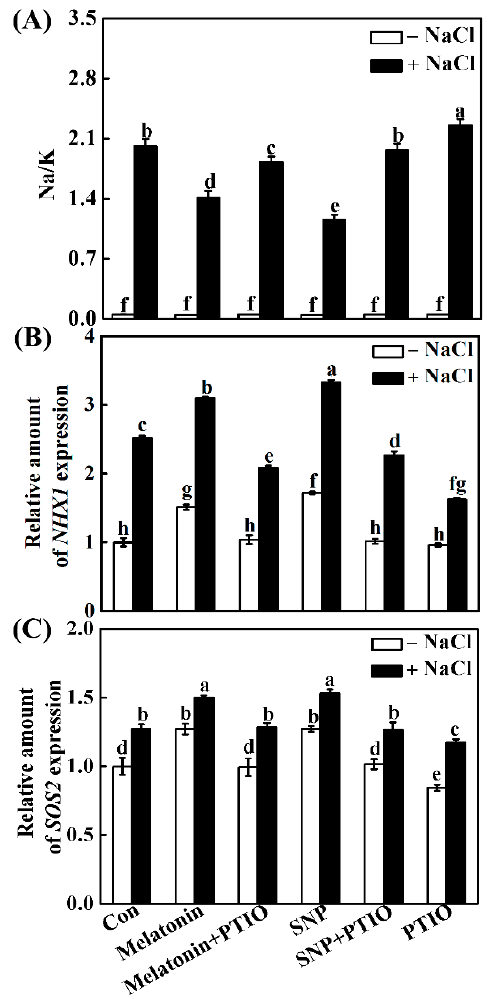
Figure 8. Melatonin modulated ion homeostasis via NO. Three-day-old rapeseed seedlings were